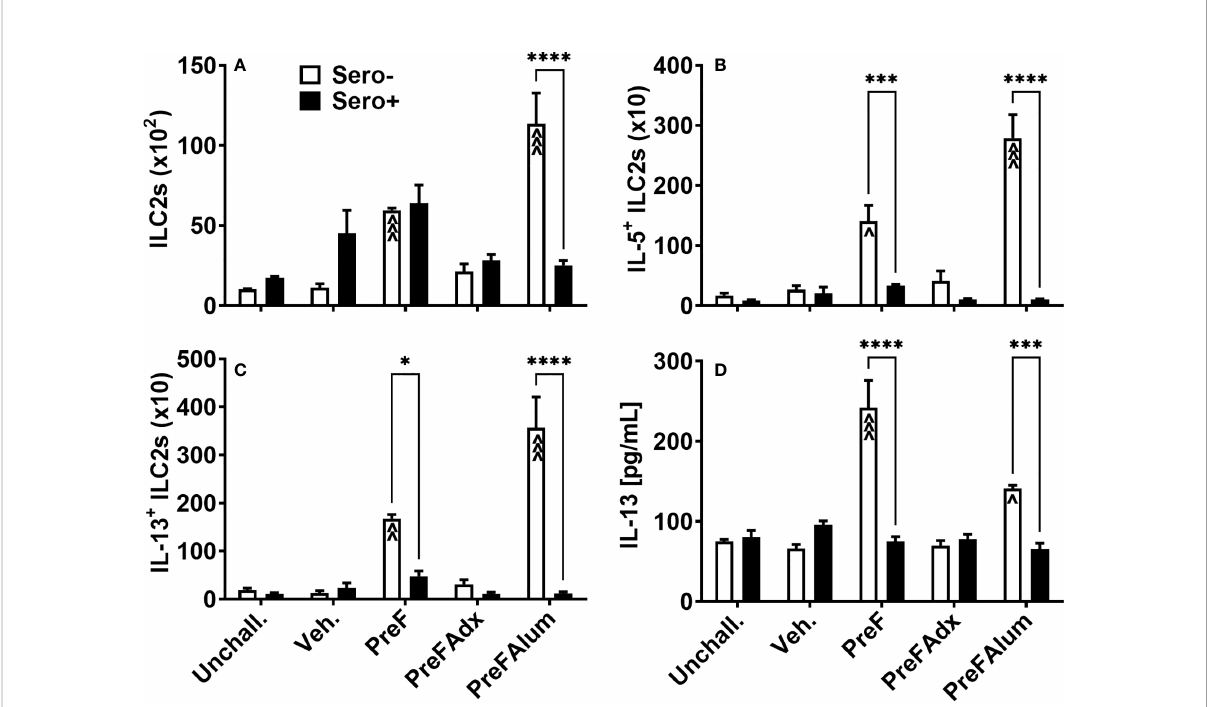
FIGURE 4 Th2-polarizing vaccine regimens are associated with increased ILC2 activation in sero- but not sero+ mice. Sero- and sero+ mice were immunized and challenged with virus as described in Figure 1. At 4dpi, lungs were harvested for quanti fi cation of ILC2s (A) , IL-5+ILC2s (B) , and IL-13+ ILC2s (C) by fl ow cytometry. IL-13 was measured in the BAL by Luminex (D) . Data are represented as mean ± SEM of two independent experiments ( n = 8 mice). Statistical signi fi cance was determined between sero- and sero+ groups within each immunization cohort using 2- way ANOVA with a Bonferroni post-test; *p<0.05, ***p<0.001, and ****p<0.0001. Comparisons to Veh controls within the respective sero- and sero+ groups were made using an ANOVA with a Dunnett ’ s multiple comparison test; ^p<0.05, ^^p<0.01, and